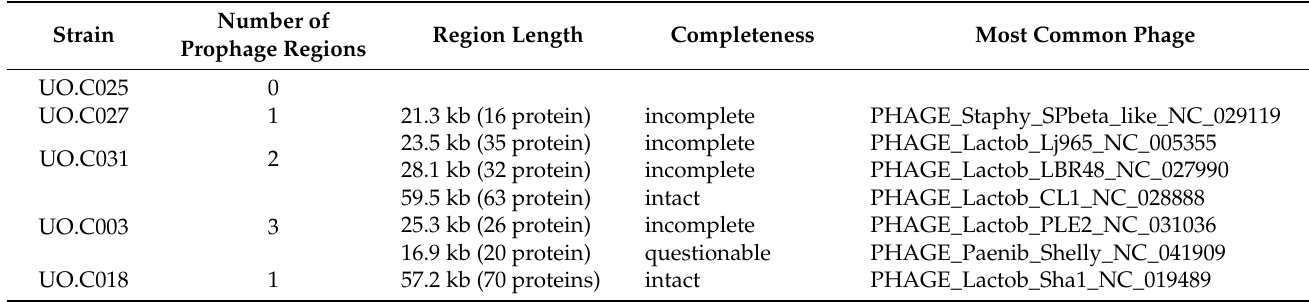
Table 5. Overview of prophage regions identified in the draft genomes of the selected bioactive strains by the PHAge Search Tool Enhanced Release (PHASTER) (Arndt et al., 2016).